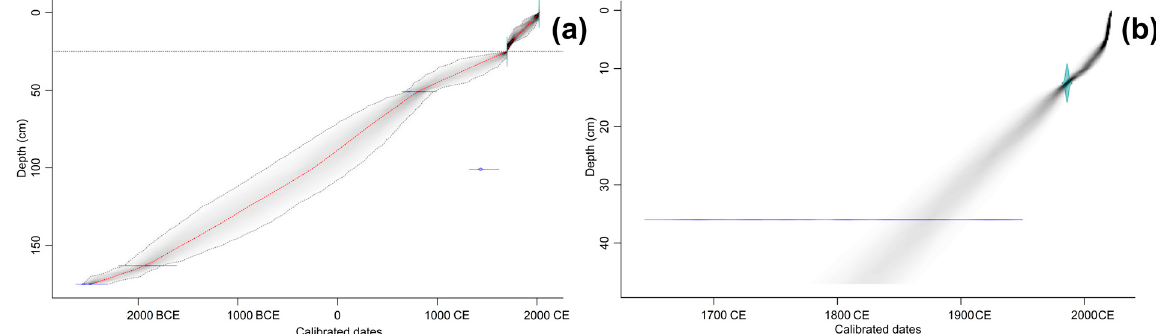
Figure 3. The age-depth model for the peat deposits of the Gorenki mire: ( a ) the undisturbed peat (the calibrated 14 C dates are shown in blue, darker greys indicate more likely ages, grey dashed lines show 95% confidence intervals, the red curve shows the single ‘best’ model based on the mean age for each sampling depth and the dashed horizontal line marks the boundary introduced by peat extraction); and ( b ) the floating mat based on 210 Pb ex , 137 Cs and 14 C dating (the green star marks a peak of 137 Cs corresponding to 1986 CE). BCE—Before Common Era, CE—Common Era.